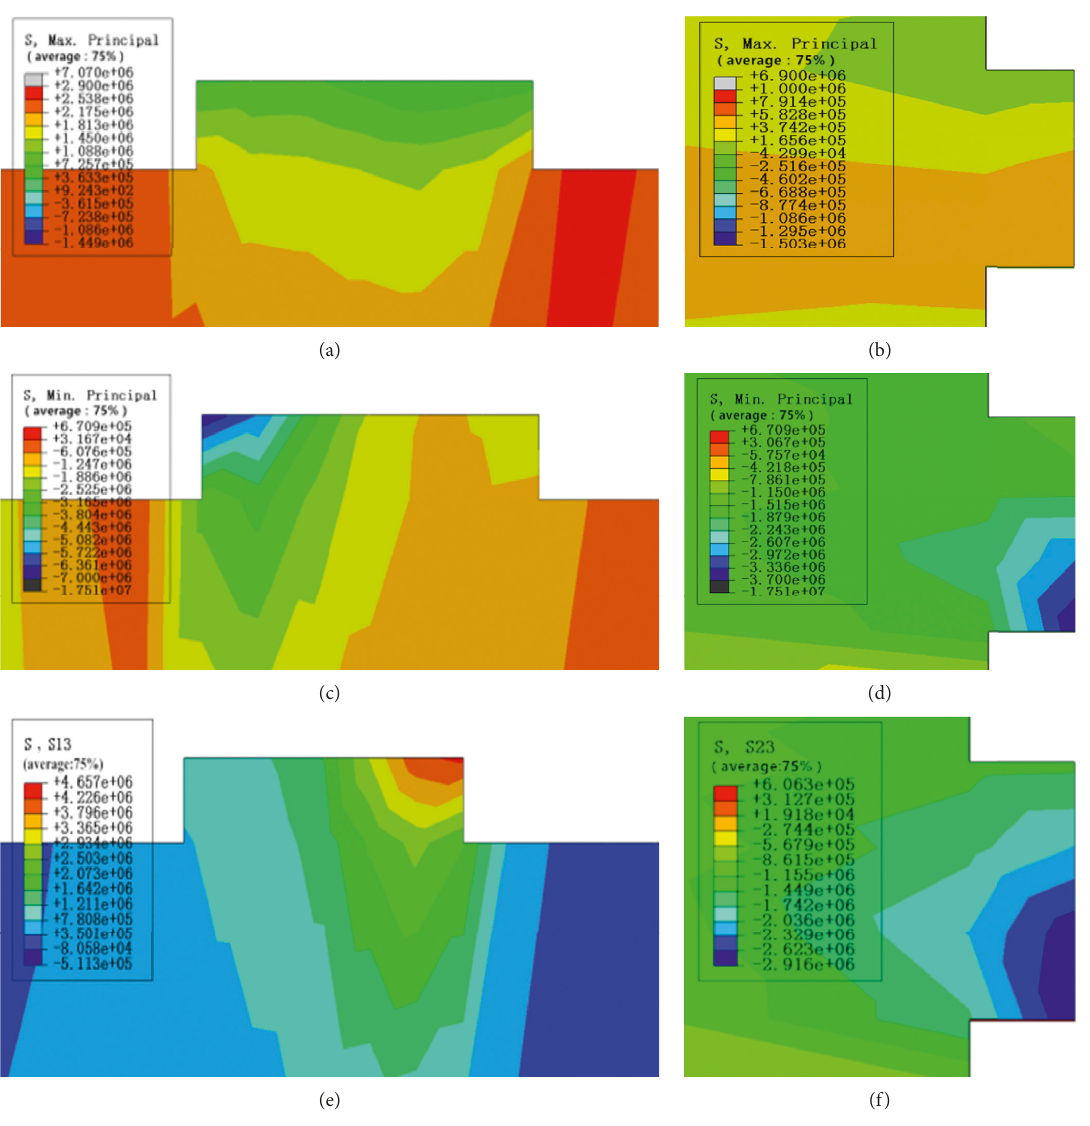
Figure 8: Shear key stress nephogram at incidence of (30 ° , 30 ° ). (a) Maximum principal stress of shear key A; (b) maximum principal stress of shear key B; (c) minimum principal stress of shear key A; (d) minimum principal stress of shear key B; (e) shear stress of shear key A; and (f) shear stress of shear key